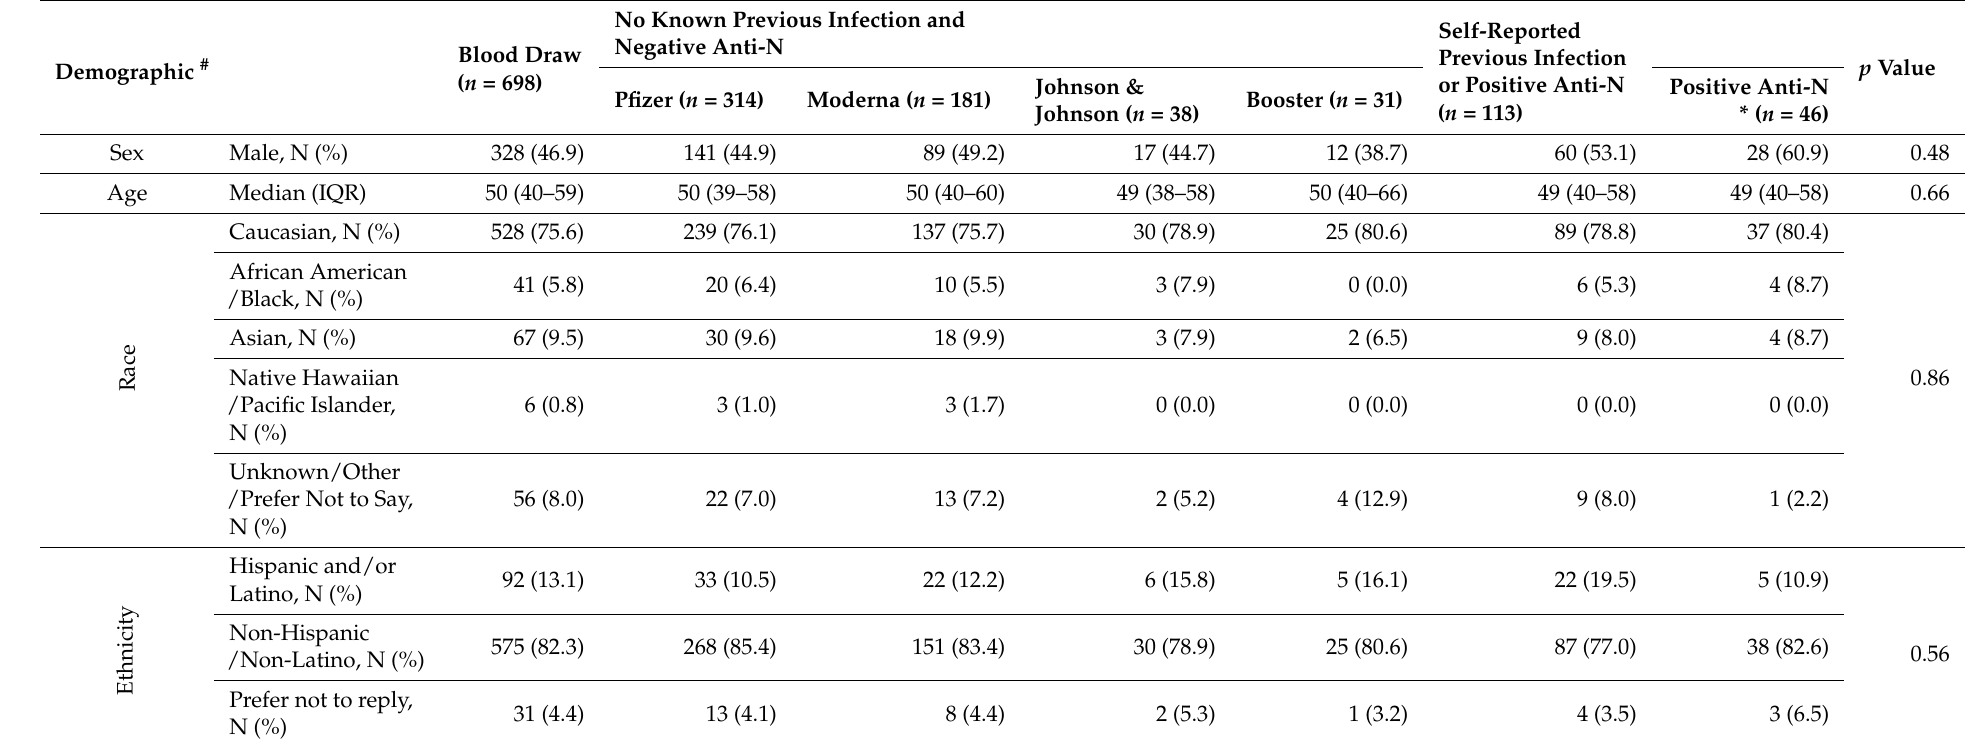
Table 1. Participant characterization and